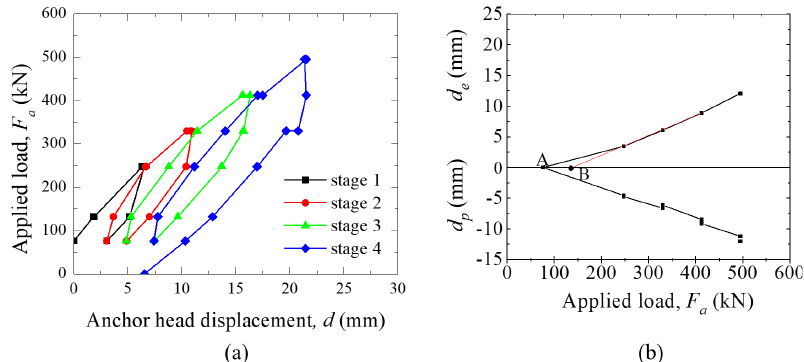
Figure 10 - Suitability test results of anchor T33: (a) Applied load v. anchor head displacement; (b) elastic and plastic displacements.